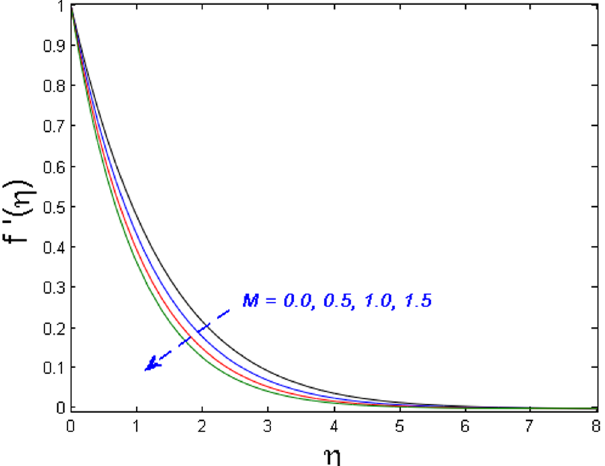
Figure 8. Effect of M on f ′ ( η ).